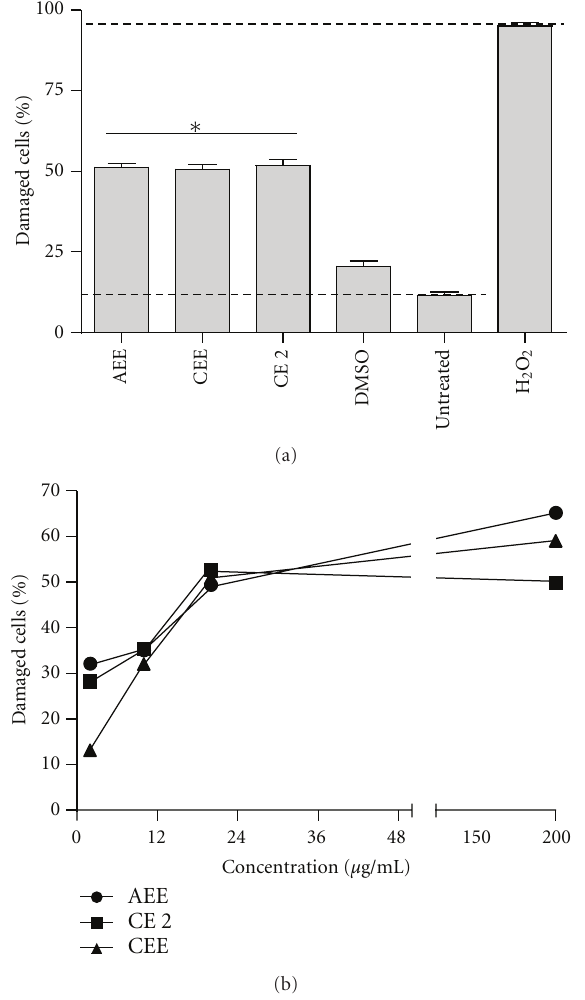
Figure 3: Cytotoxic e ff ects of compounds from Laennecia confusa . (a) THP-1 cells were used to assess the cytotoxic e ff ects of bioactive compounds using propidium iodine staining and the obtained values were used to calculate the IC 50 (b). Dashed lines represent treatment with 5% H 2 O 2 (upper line) (positive control) and untreated cells (lower line) (negative control). Shown is the mean ± SD of three independent experiments. CE is a chloroformic fraction, and AEE and CEE are aqueous and chloroform extracts, respectively. ∗ P value < 0.0001.